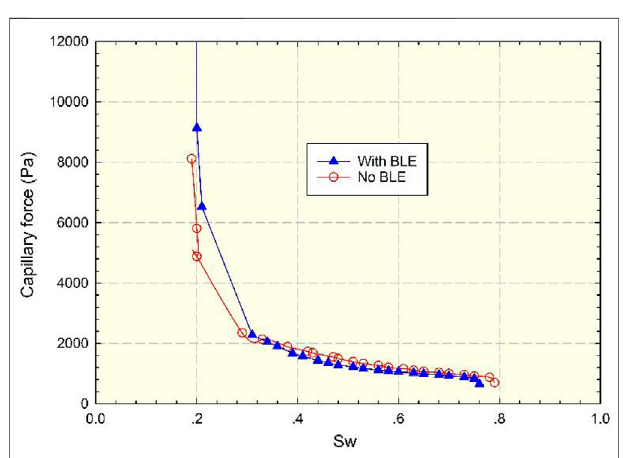
FIGURE 18 | Comparison of capillary forces with BLE.